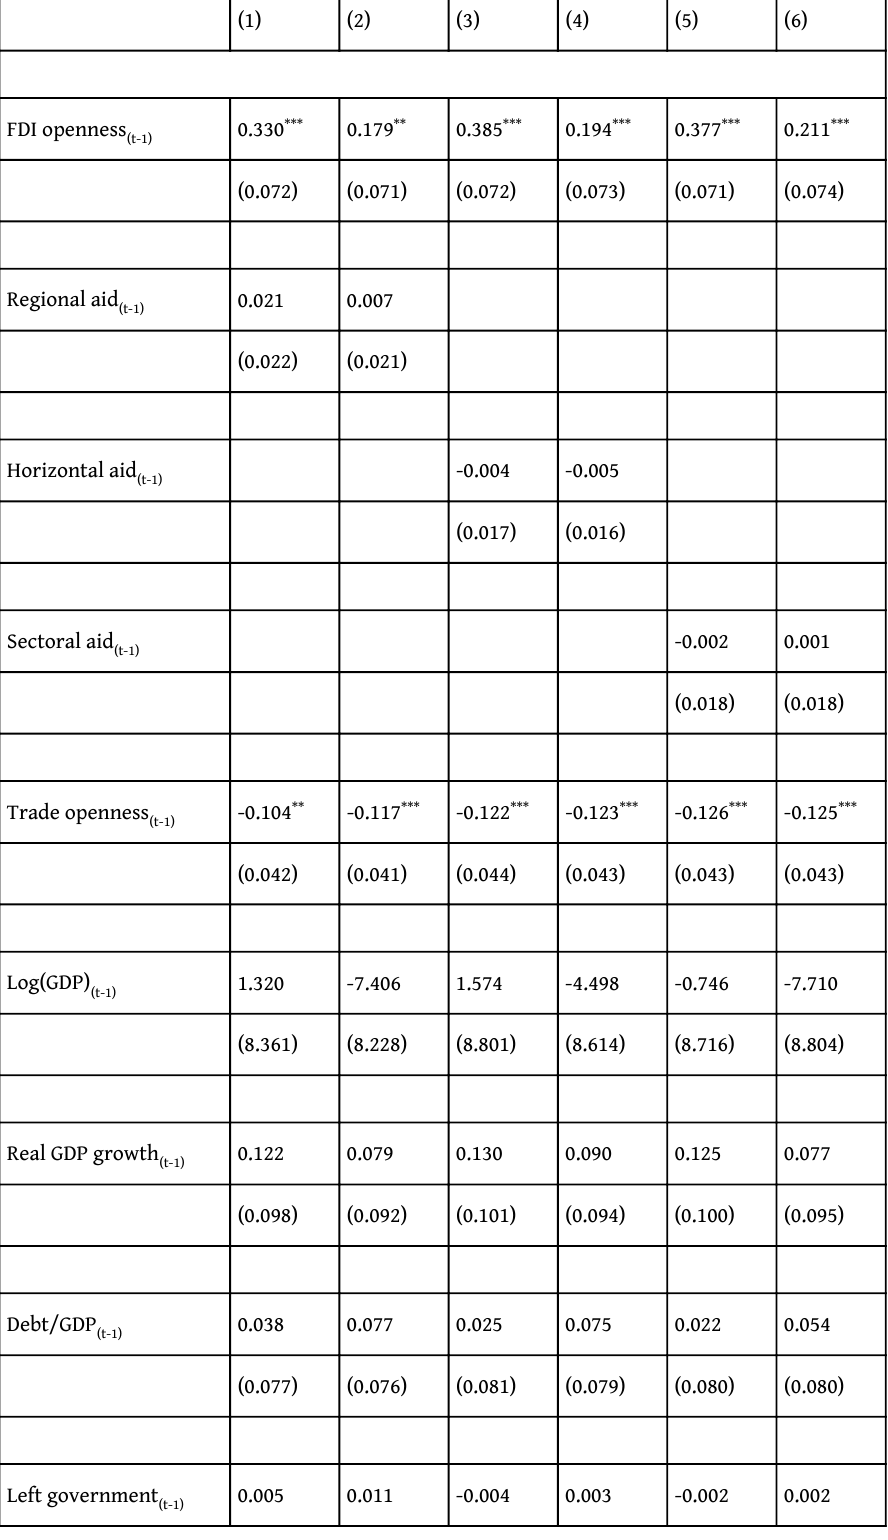
Table A1: The effect of aid allocations on FDI openness (2000-18), ADL